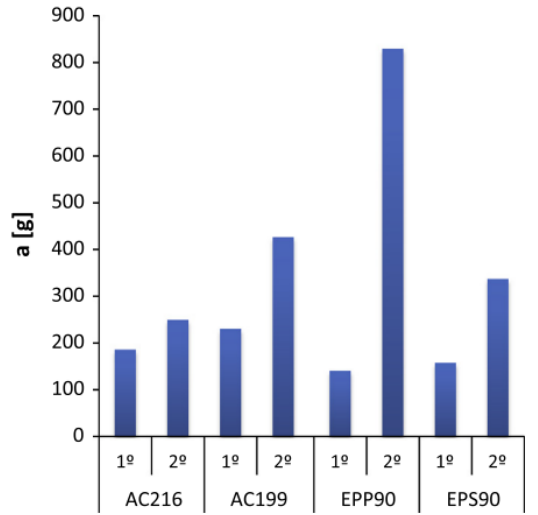
Figure 7. Impactor acceleration after the first and second impact for two agglomerated corks (AC) with 216 and 199 kg/m 3 density and EPP and EPS foams with 90 kg/m 3 density (Reprinted and adapted with permission from [62]).